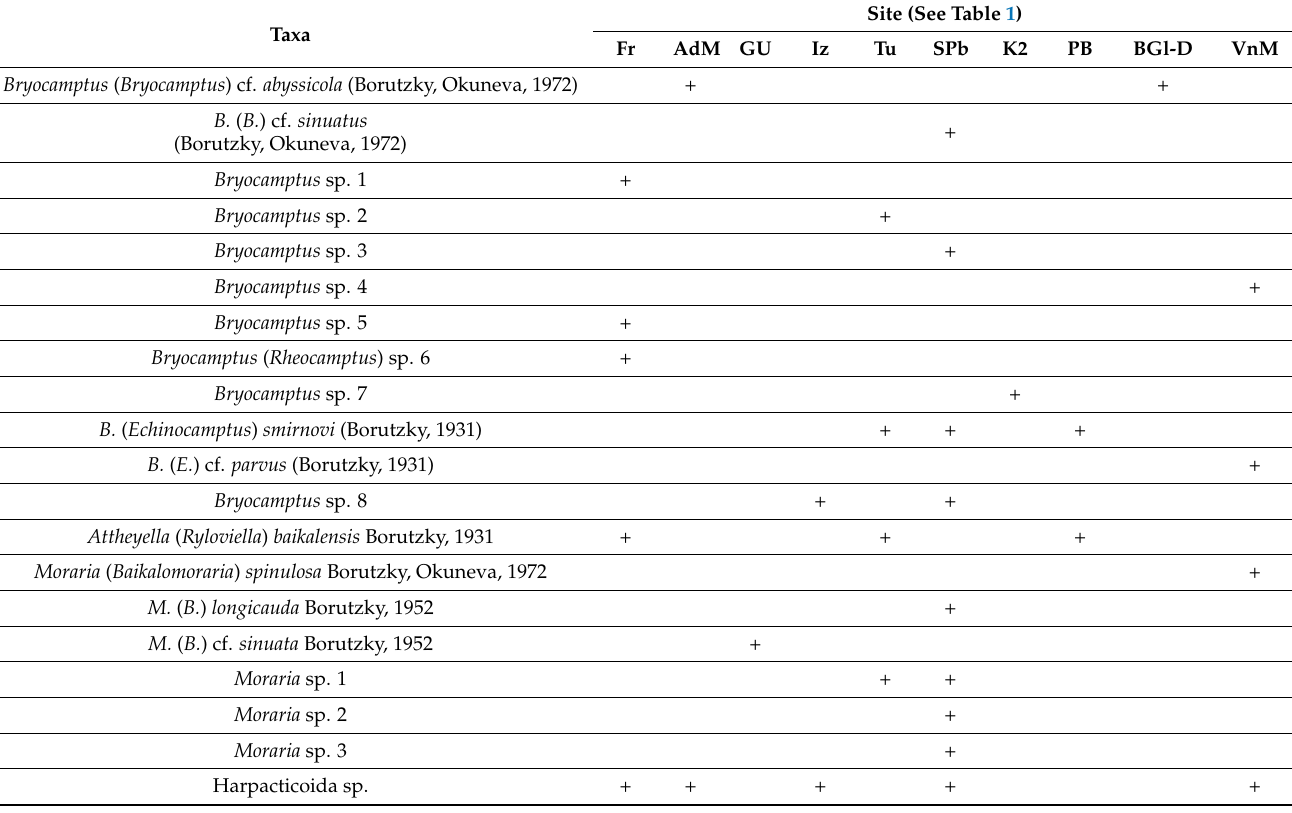
Table 3. Taxa structure of harpacticoids in the studied sites of the deep-water zone of Lake Baikal. Site (See Table 1) Taxa Fr AdM GU Iz Tu SPb K2 PB BGl-D